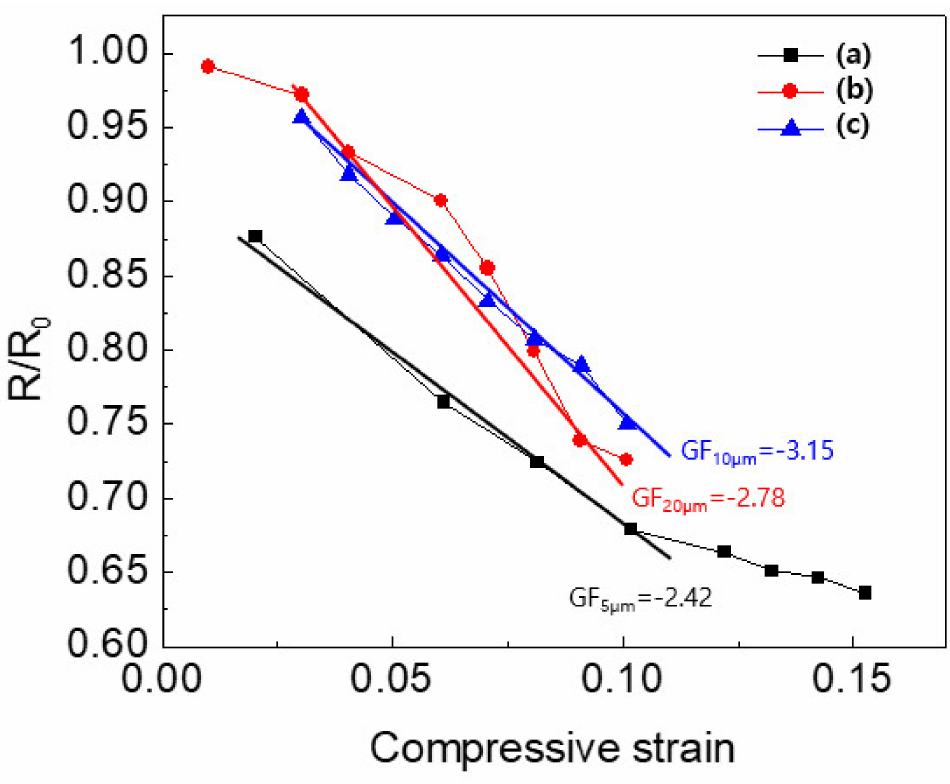
Figure 4C. Strain gauge factor of ( a ) TPU-(MWCNT-PMMA) (5 µ m), ( b ) TPU-(MWCNT-PMMA) (10 µ m) and ( c ) TPU-(MWCNT-PMMA) (20 µ